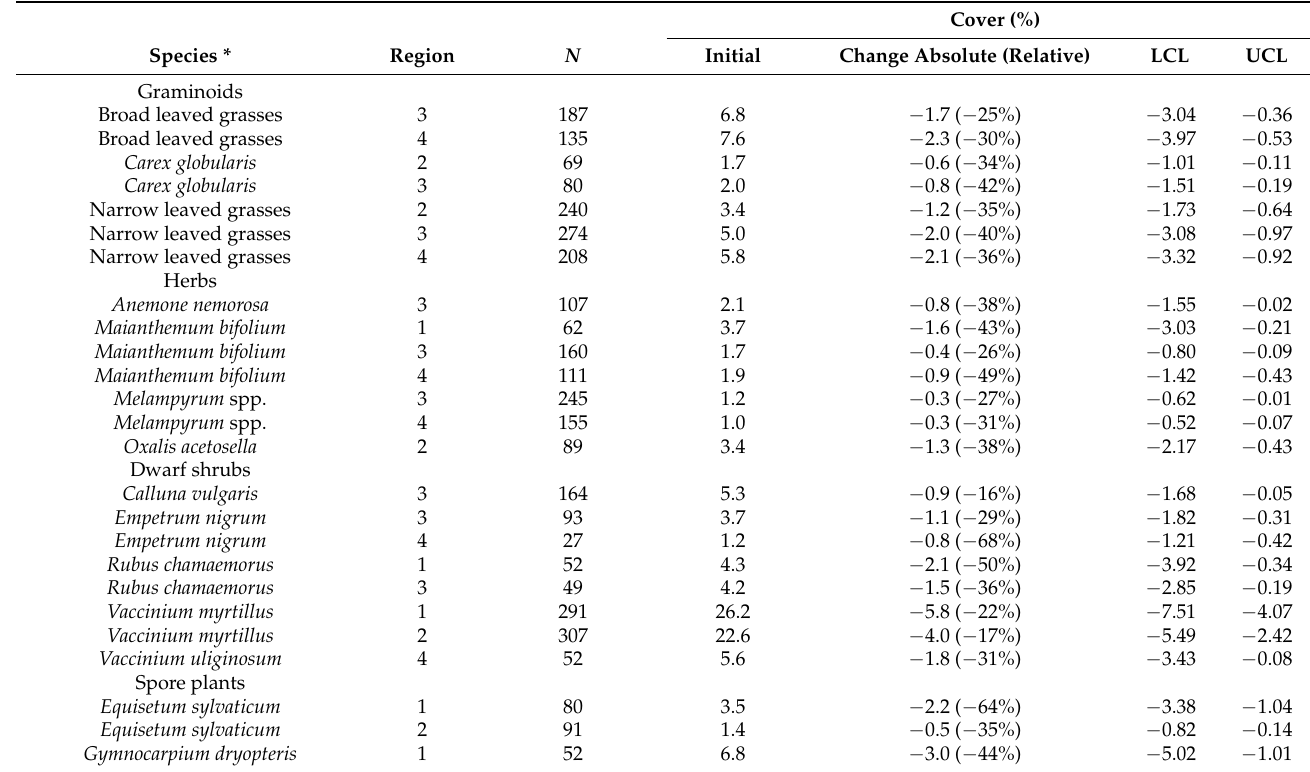
Table 3. Species showing significant changes ( p < 0.05) in cover in individual regions (see Figure 1). Initial cover denotes the average cover for the first inventory year while the absolute change and the relative change refers to the average change occurring after 10 years. N refers to the number of plots included in the analysis. The 95% confidence interval for the absolute change is defined by its two limits: the Lower Confidence Limit (LCL) and the Upper Confidence Limit